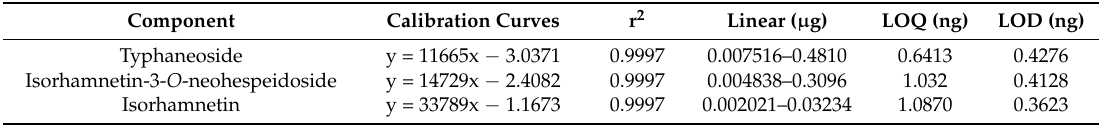
Table 7. Calibration curves, limits of detection (LOD), and limits of quantitation (LOQ) of the three